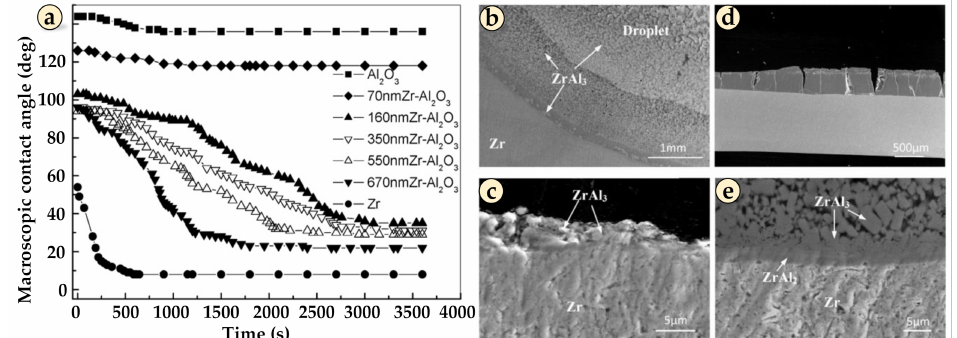
Figure 10. Wettability improvement by Zr coating on Al 2 O 3 reinforced Al composite. ( a ) macroscopic contact angle versus time in isothermal condition at 700 ◦ C, ( b ) top-view SEM image of solidified sample, ( c ) cross-sectional view SEM of the interface between precursor and substrate, ( d , e ) the cross- sectional SEM image taken from the center of the droplet reproduced from [142] with permission of Elsevier,